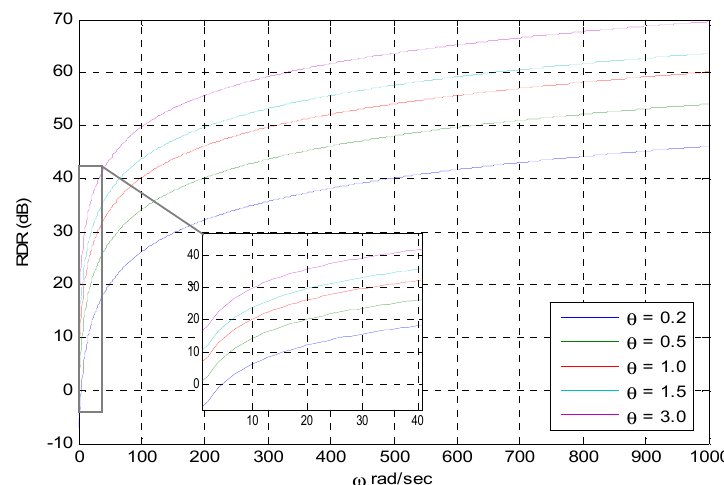
Figure 5. RDR spectra of C θ ( s ) controllers for several θ values. This figure reveals the adjustment of RDR performance according to several θ configurations.